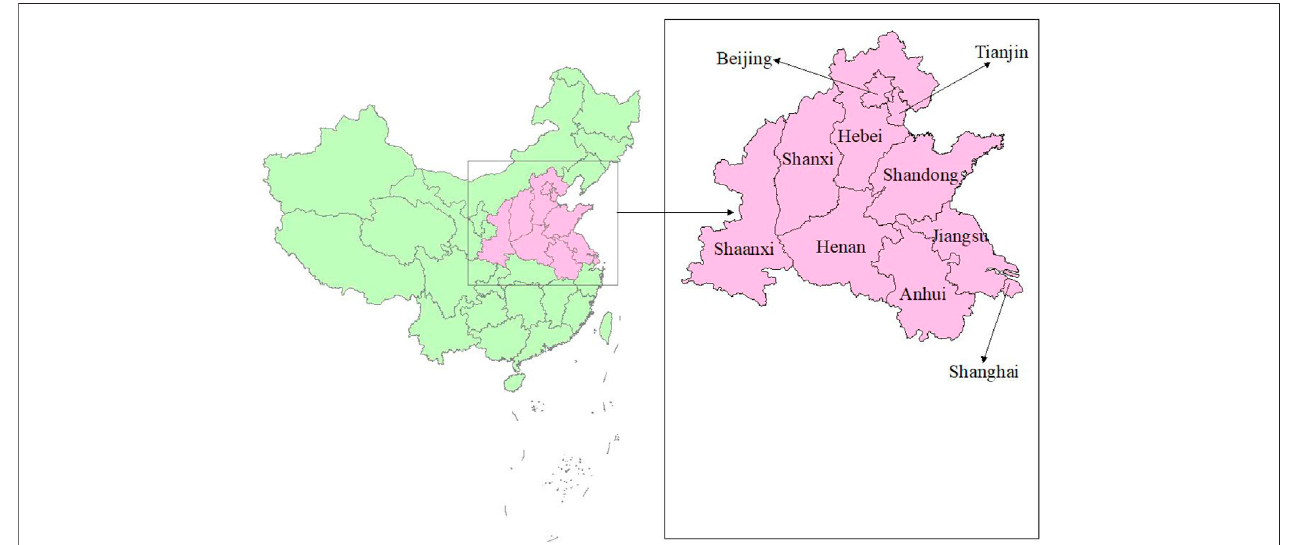
FIGURE 1 | Geographical location of seven provinces and three cities.